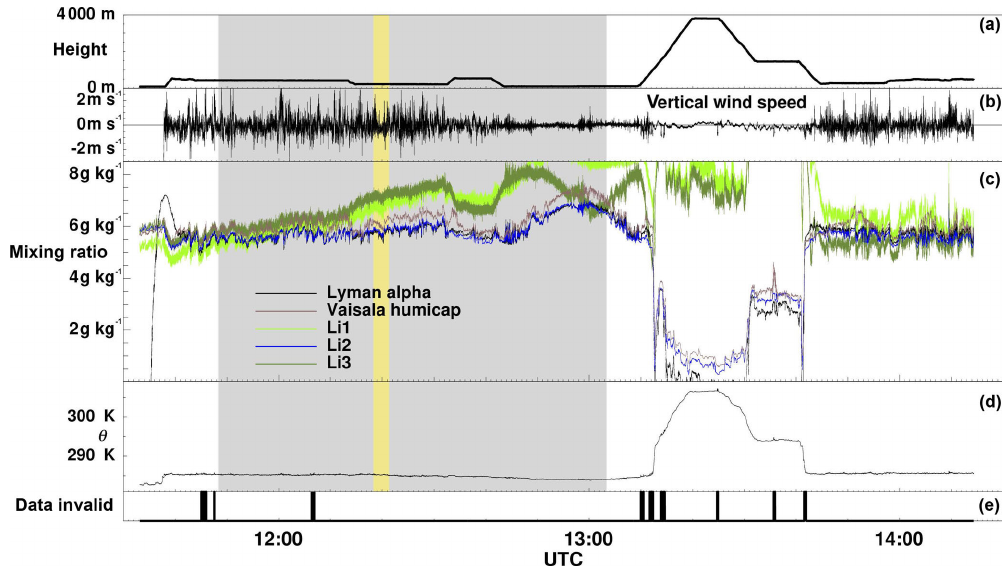
Figure 3. Overview of the flight with the Do128 on 23 October 2015. Panel (a) shows the height and (b) the vertical wind speed, indicating the strength of atmospheric turbulence. Panel (c) shows the time series of the mixing ratio measured by Lyman-alpha (black), Vaisala Humicap (purple), closed-path Li2 (blue), open-path Li1 at the nose boom (bright green) and closed-path Li3 on the cabin roof (olive). Panel (d) provides the potential temperature. Panel (e) shows the periods of invalid data, e.g. when radio communication disturbed the signals. For the spectral analysis, the part of the data shaded in grey was used, excluding segments with invalid data, e.g. disturbance from radio communication. The vibration data are analysed for the flight segment indicated in yellow.